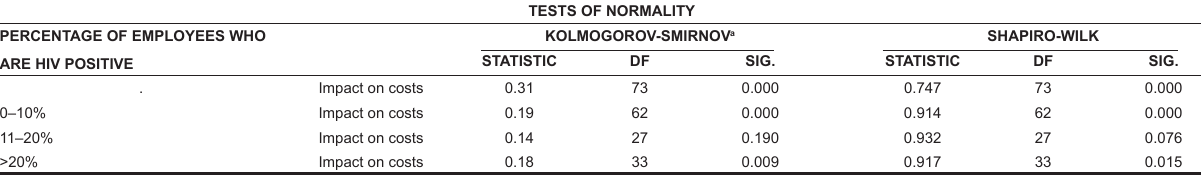
TABLE 14 Tests of normality (question 10)